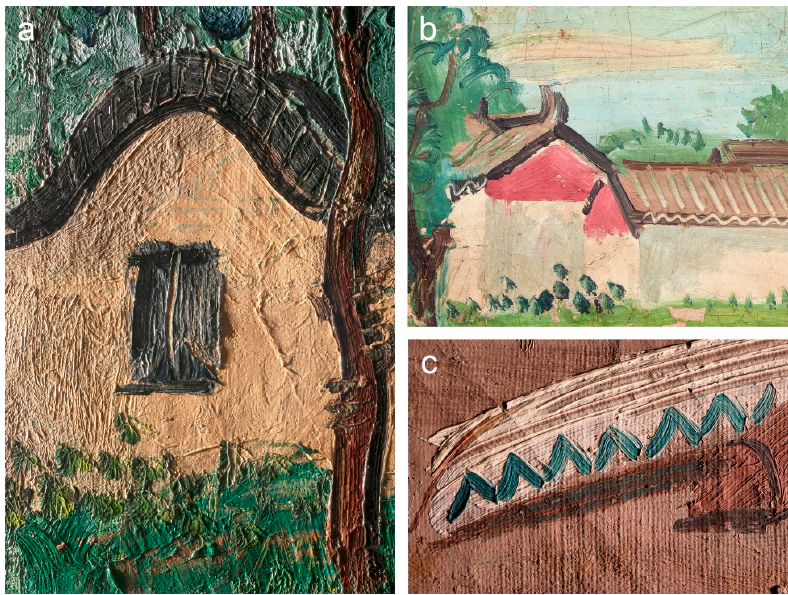
Figure 17. Details showing different descriptive painting techniques like calligraphic outlining, scraping into wet paint and building moderate impastos in: ( a ) Chinese house , 1934; ( b ) Pagoda , 1936; ( c ) Seaside , 1936.